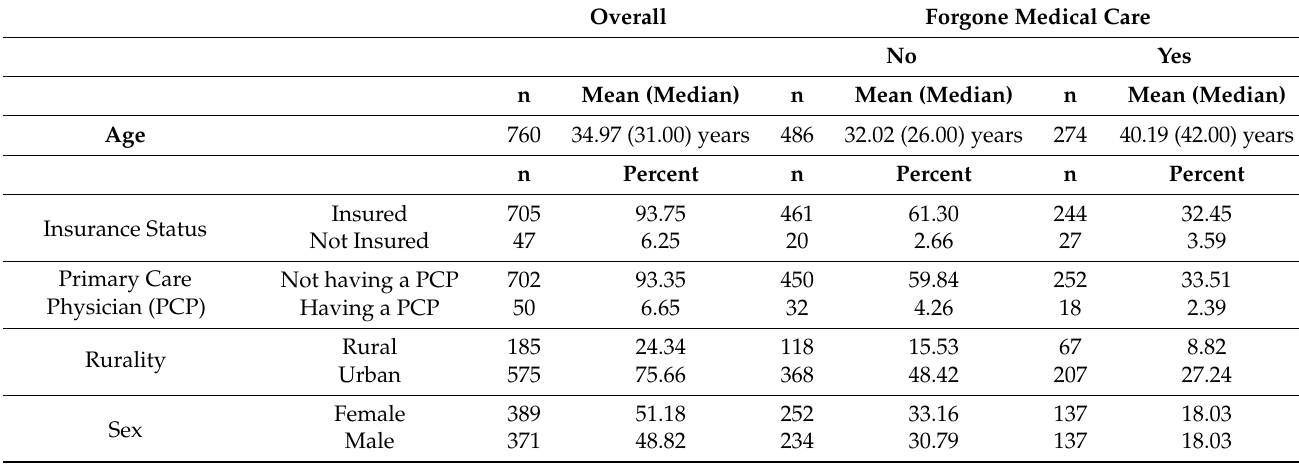
Table 1. Description of the study population overall and by forgone medical